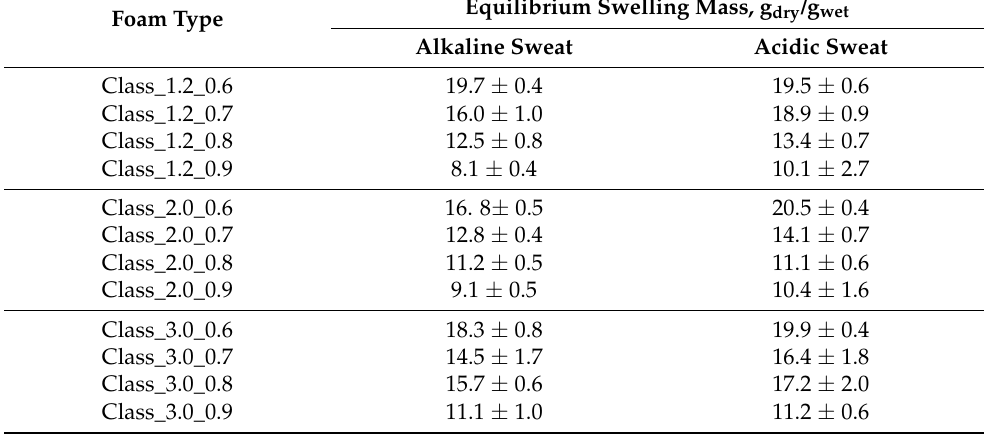
Table 9. Comparison of equilibrium swelling ratio for sweat with alkaline and acidic pH depending on I NCO and water